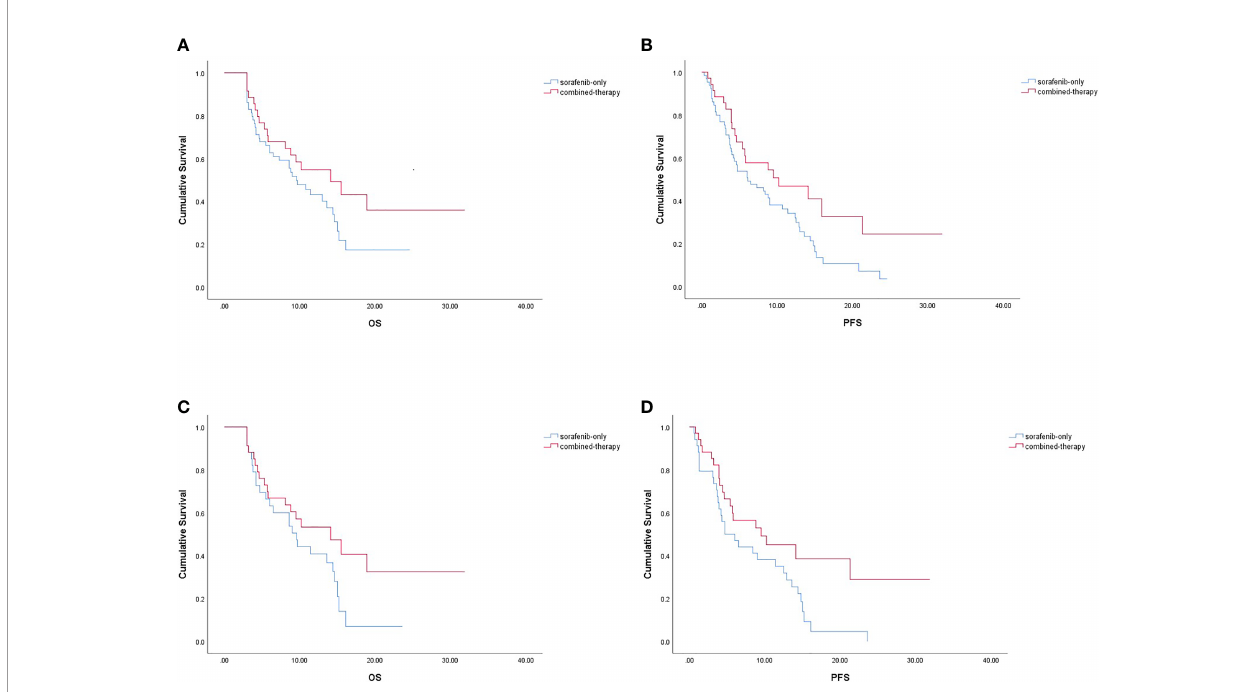
FIGURE 1 | Kaplan-Meier survival curve. OS (A) and PFS (B) in the combined-therapy group and the sorafenib-only group before PSM. OS (C) and PFS (D) in the combined-therapy group and the sorafenib-only group after PSM. OS, overall survival; PFS, progression-free